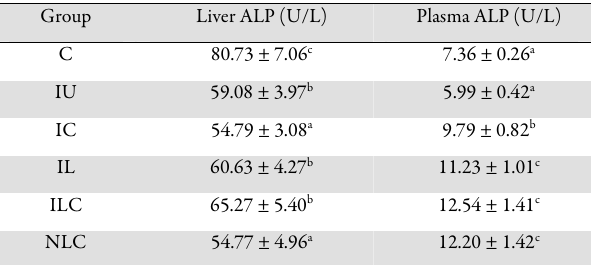
Table 3. The effect of lumefantrine and lumefantrine - copper complex on the specific activity of alkaline phosphatase (ALP) in the liver and plasma of P. berghei NK-65 infected mice